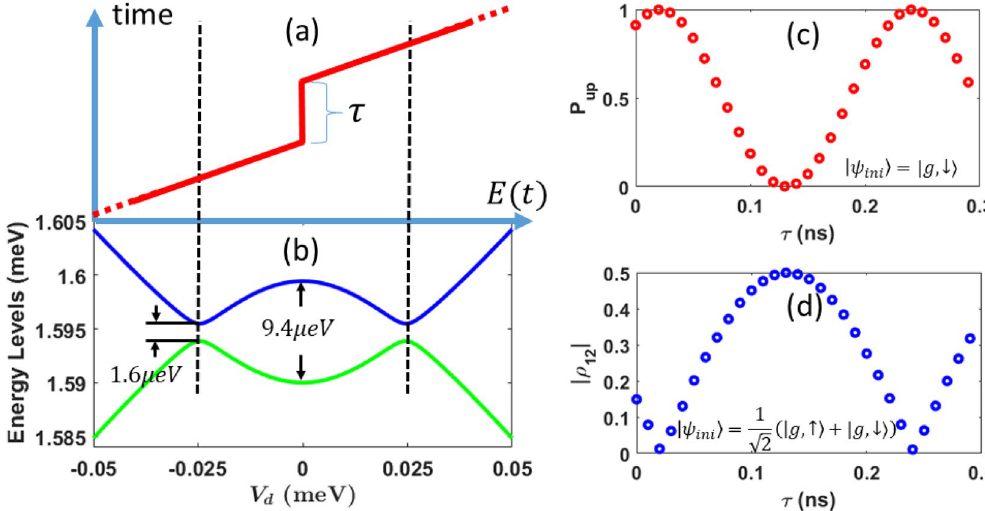
Figure 7. ( a ) Schematic diagram of pulse shape for tuning LZS interference. A plateau is inserted in an otherwise linearly increasing electric field. The duration of the plateau is given by parameter τ . ( b ) Energy diagram near zero detuning. The full energy diagram is given in Fig. 2(b) with two other levels. The actual electric field increases from − 1500 V/m ( V d = 2 eEd ≈ − 0.14 meV) to 1500 V/m ( V d ≈ 0.14 meV). ( c ) Spin-up probability ( P up ) in the final state after an extra waiting time τ is inserted at the point V d = 0 in the electric field pulse. The initial state is ψ | 〉 = | ↓ 〉 g , . ( d ) Matrix elements of reduced density matrix ρ . The initial state is ini 1 . The applied magnetic field is chosen as B = 1.3 T, total operation time without ψ | 〉 = | ↑  〉 + |  ↓〉 g g ( , , ) ini 2 counting τ is 2 T − τ = 20